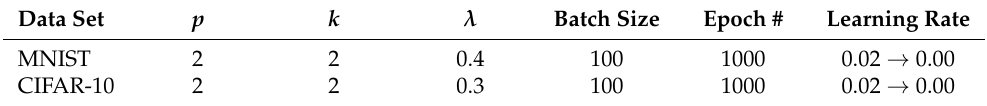
Table 1. Learned hyperparameter values for the unsupervised part of the biologically plausible model.